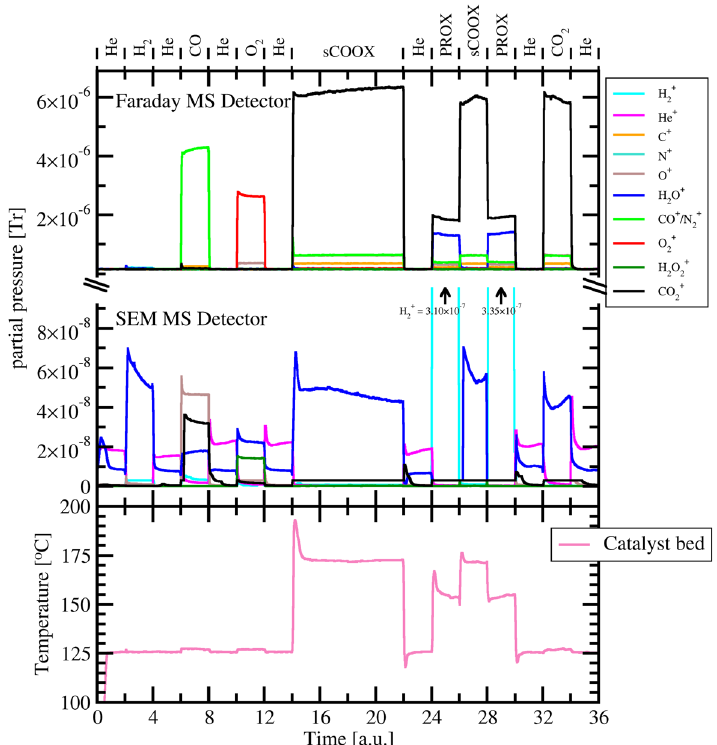
Figure 2. MS probed outlet gas composition and thermocouple measured catalyst bed temperature for the sequential experiment with Au/ CeO 2 catalyst in the glass reactor. The time scale corresponds to 30 min per